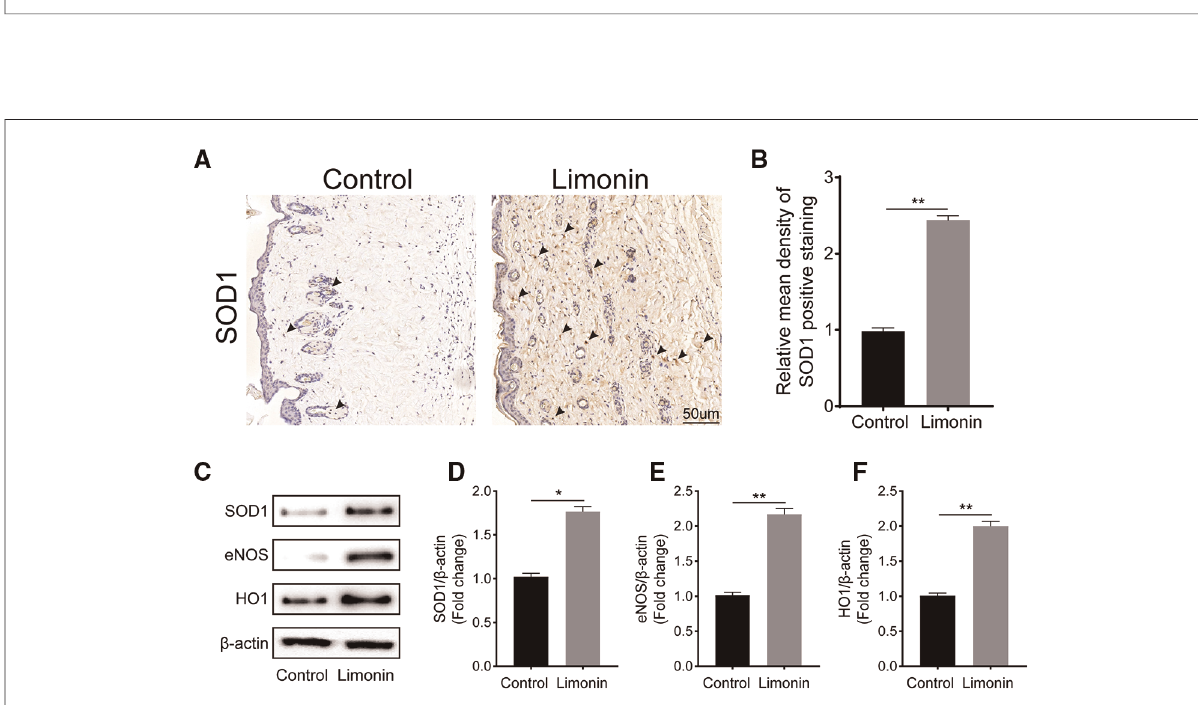
FIGURE 5 Limonin attenuates oxidative stress in the ischemic area of the fl aps. ( A ) Immunohistochemistry for superoxide dismutase 1 (SOD1) expression in the fl aps of each group (original magni fi cation ×200; scale bar, 50 µm). ( B ) Histograms of optical density values of SOD1 by immunohistochemistry in each group. ( C ) Western blotting for SOD1, endothelial nitric oxide synthase (eNOS), and heme oxidase 1 (HO1) protein expression in the skin fl aps. Gels were electrophoresed under the same experimental conditions, and cropped blots are shown here. ( D – F ) Histograms of the optical density values of SOD1, eNOS, and HO1 in the two groups as evaluated by Western blotting. Data are means±standard error of the mean, n =6 per group. * P <0.05 and ** P <0.01, vs. control